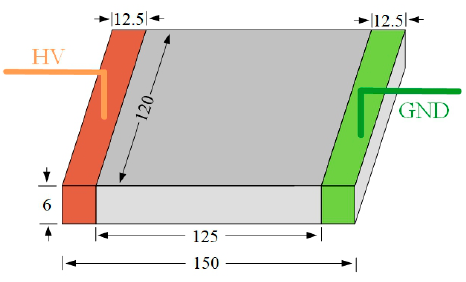
Figure 1. Tested samples (unit: mm).